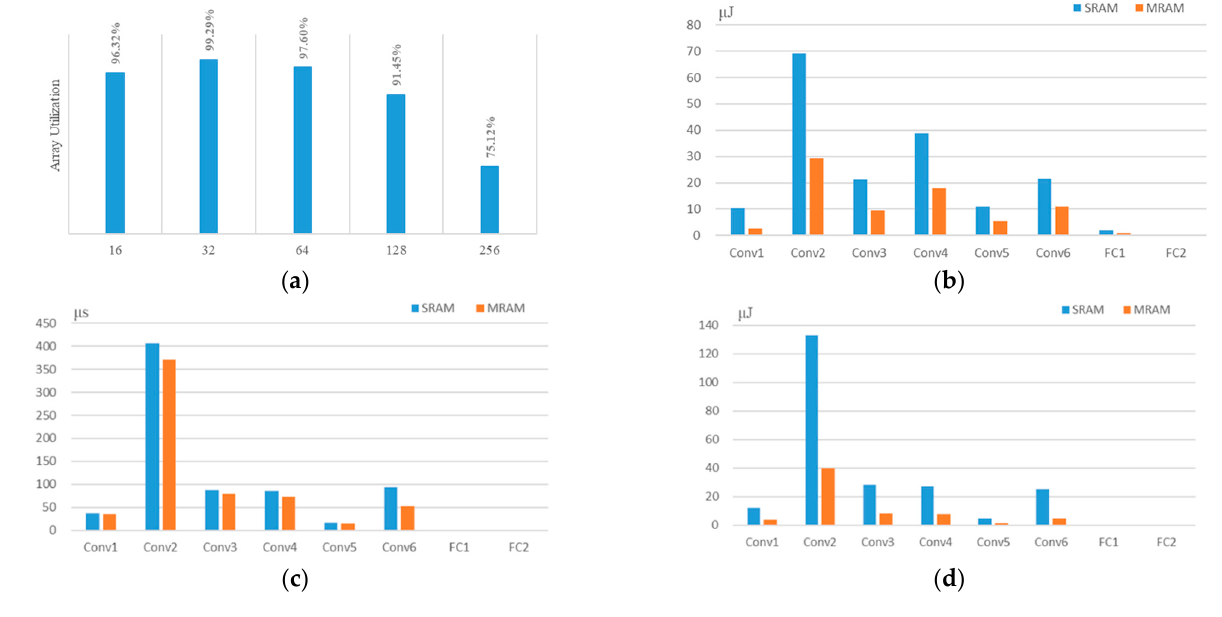
Figure 7. ( a ) Relationship between array utilization and SU size; layer-wise, ( b ) dynamic energy, ( c ) latency, and ( d ) leakage energy comparison between skyrmionics and SRAM.